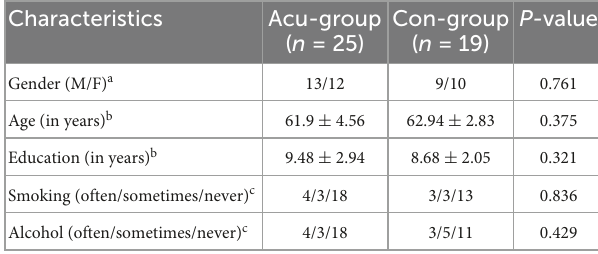
TABLE 1 Demographics at the